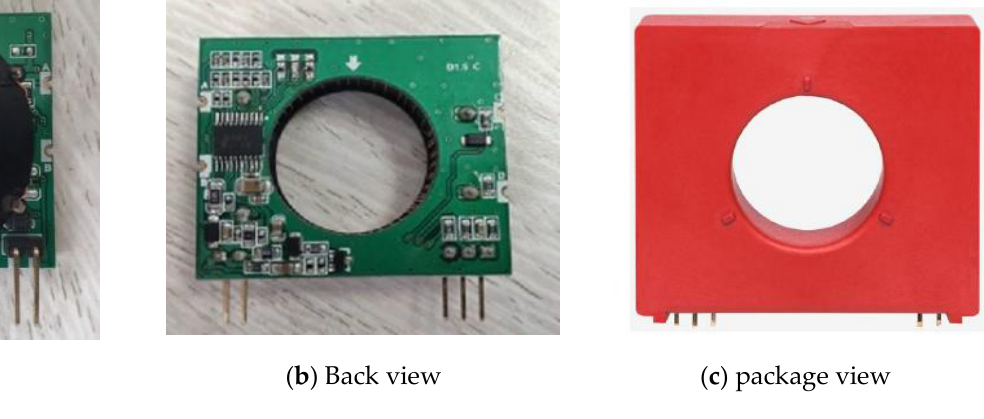
Figure 14. DC leakage circuit breaker prototype.